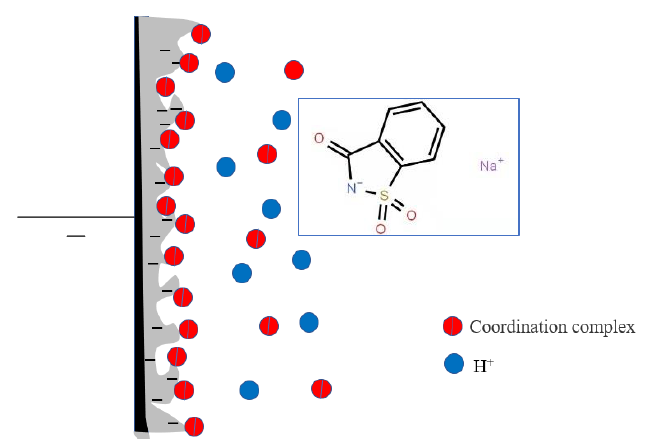
Figure 11. The structure of the complex of saccharin sodium and Fe 2+ at the electrode/solution inter- face.